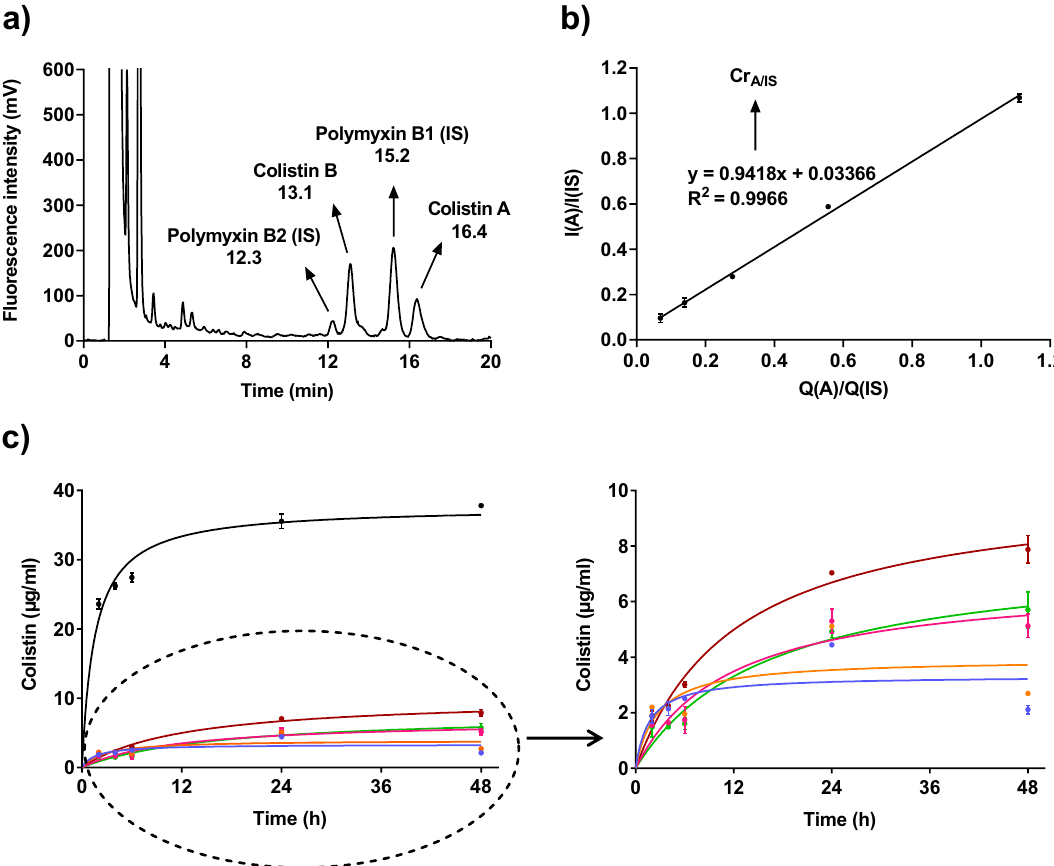
Figure 1. Optimization of colistin detection and quantification using high-performance liquid chromatography-fluorescence detection. ( a ) A typical chromatogram showing colistin detection in a polymyxin B spiked sample following colistin diffusion through artificial sputum (AS) medium. ( b ) Calibration curve of colistin. ( c ) Colistin quantification in the lower Transwell compartment after diffusion through AS medium ± OligoG at 0.5, 1 and 2% added to the surface of AS medium or pre-incubated for 4 h (± SD; n = 3). Abbreviations: PBS (black), AS (blue), 1% OligoG (surface treatment; orange), 0.5% OligoG (4 h pre-incubation; pink), 1% OligoG (4 h pre-incubation; green), 2% OligoG (4 h pre-incubation;